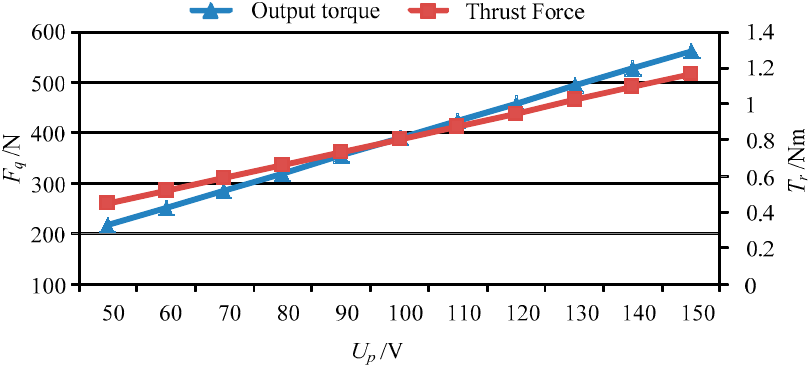
Figure 13. The output torque and thrust force vary with U p .